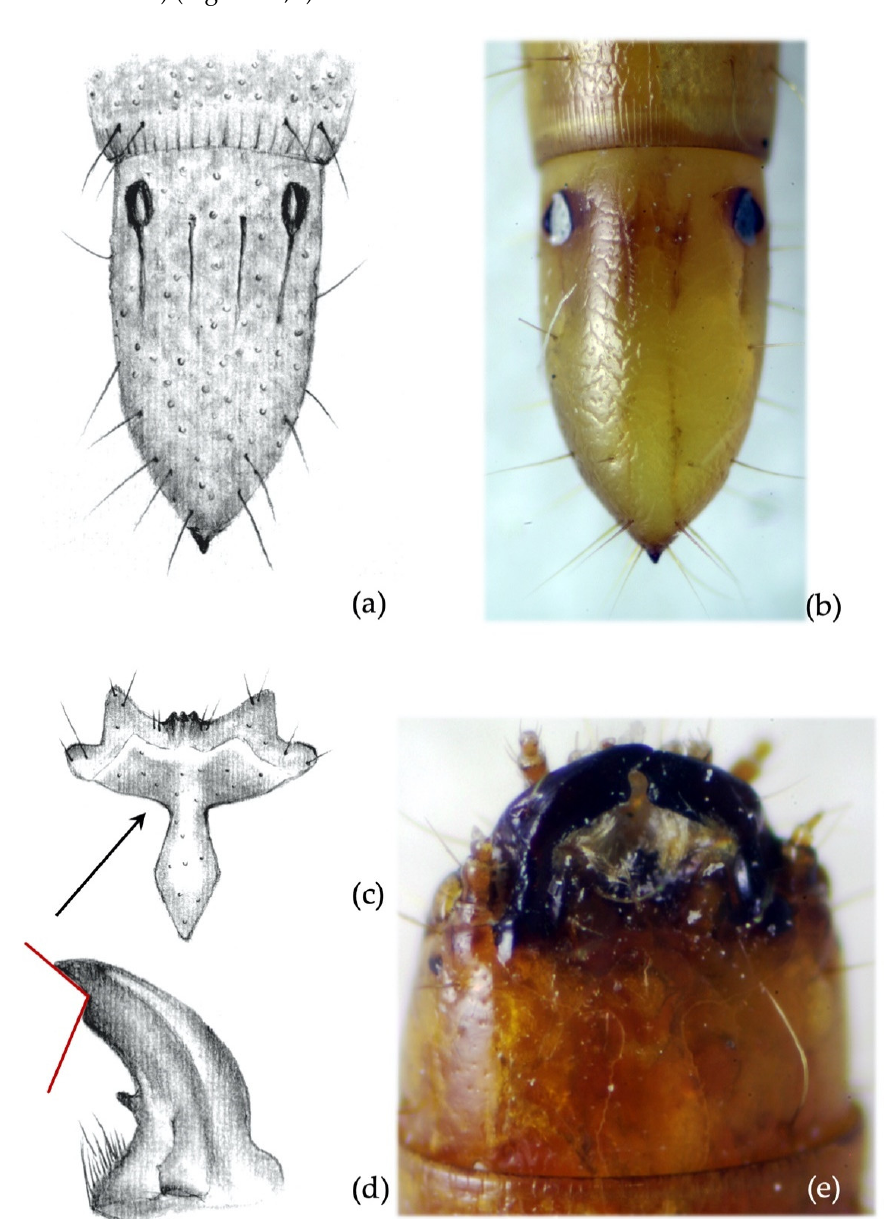
Figure 8. Agriotes sputator (L. 1758). ( a , b ) Ninth abdominal segment with longitudinal lines and punctures; ( c ) details of the frontoclypeus, forming an angle slightly >90° on at least one side; ( d ) details of the right mandible with subapical tooth forming a measured angle ranging from 90–100°; ( e ) view of the head with frontoclypeus and mandibles.